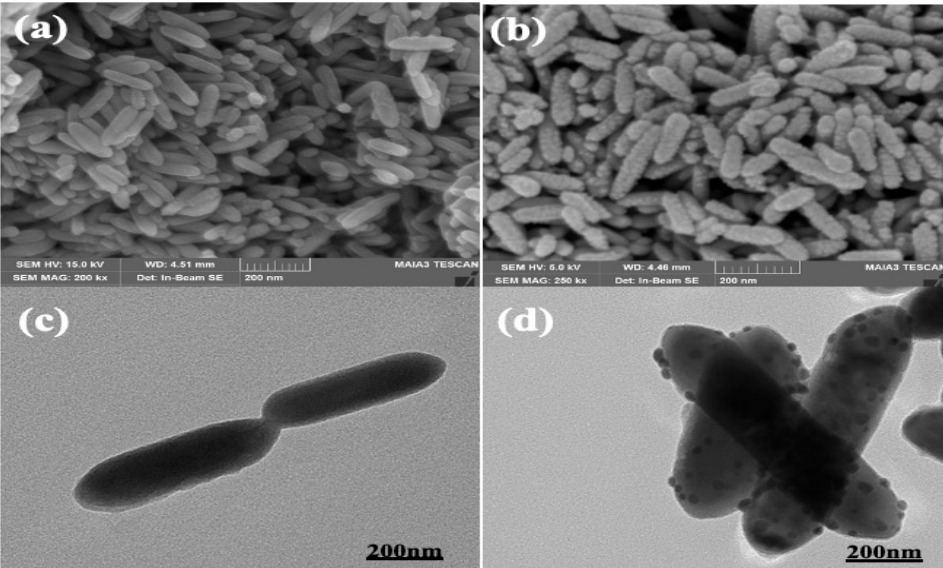
Figure 1. SEM micrographs of Se-Te and Se-Te@Au nanorods, respectively ( a , b ). TEM images of Se-Te and Se-Te@Au rods, respectively ( c , d ).